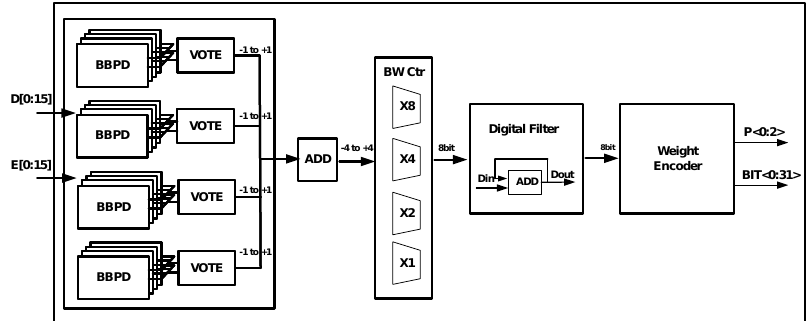
Figure 7. CDA architecture.